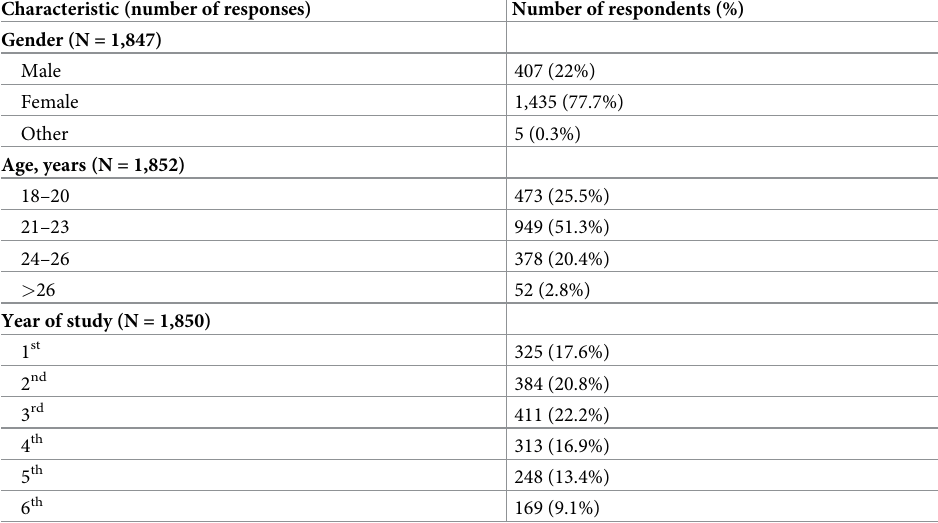
Table 1. The study group characteristics (N =